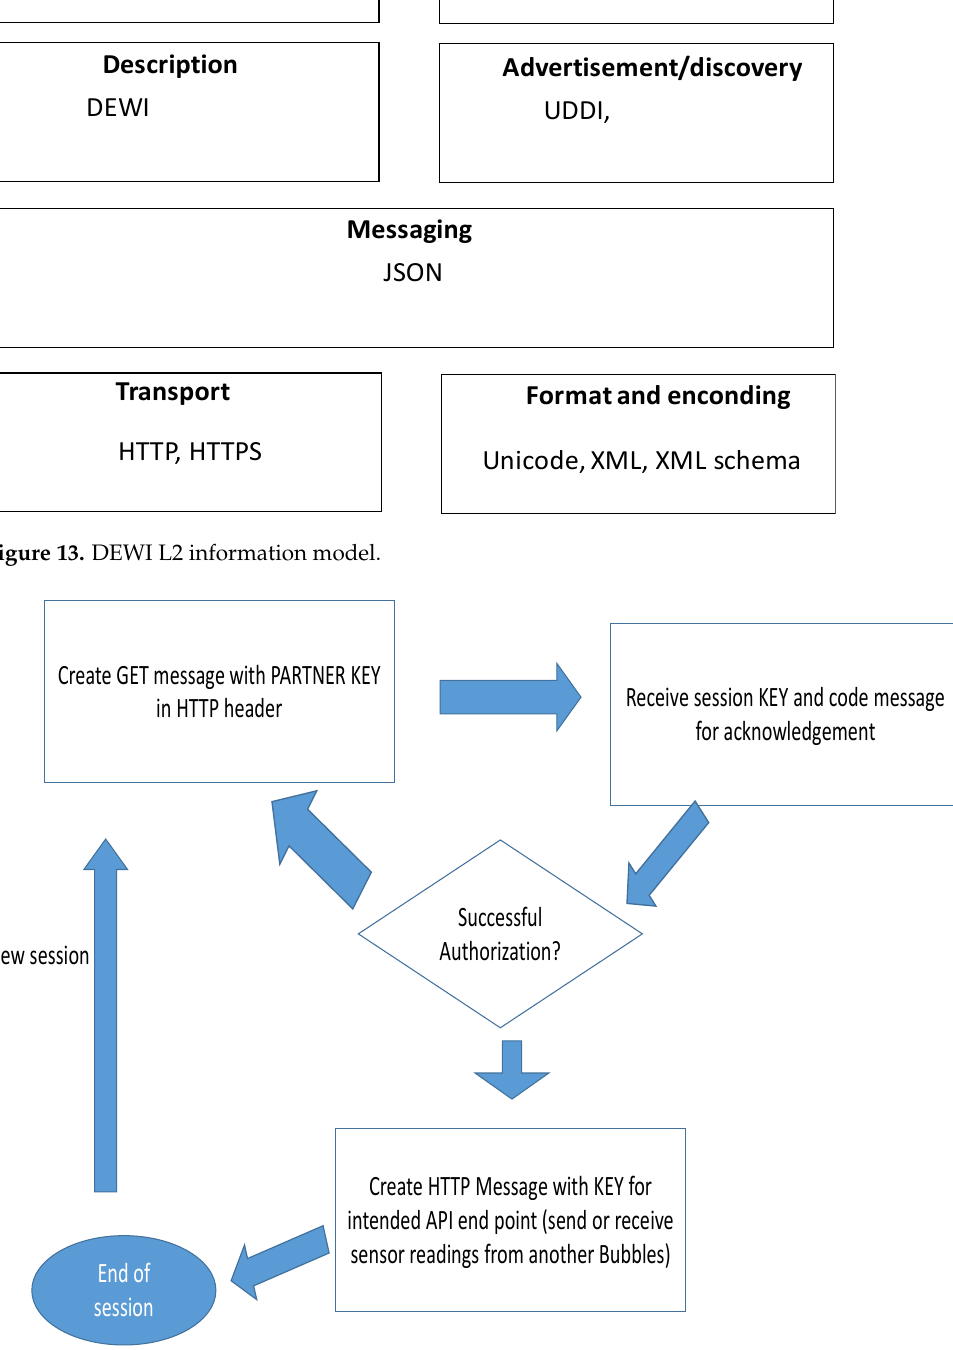
Figure 14. DEWI L2 technology user